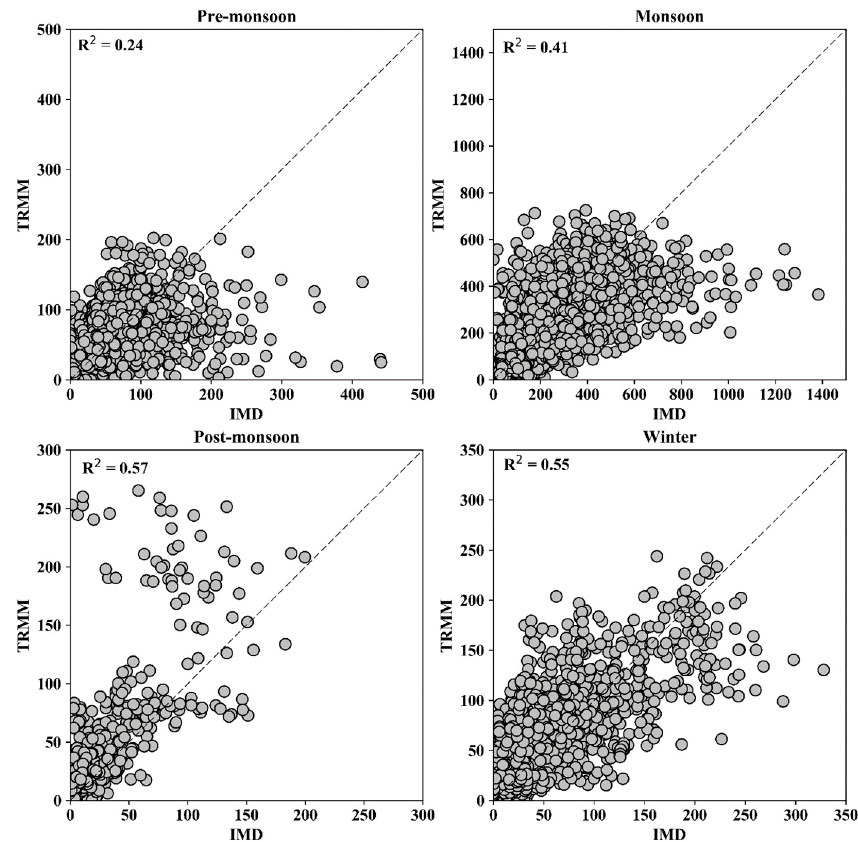
Figure 4. Scatter plot of IMD precipitation against raw TRMM precipitation representing correlation for four seasons (pre-monsoon, monsoon, post-monsoon and winter) in the Upper Ganga basin.